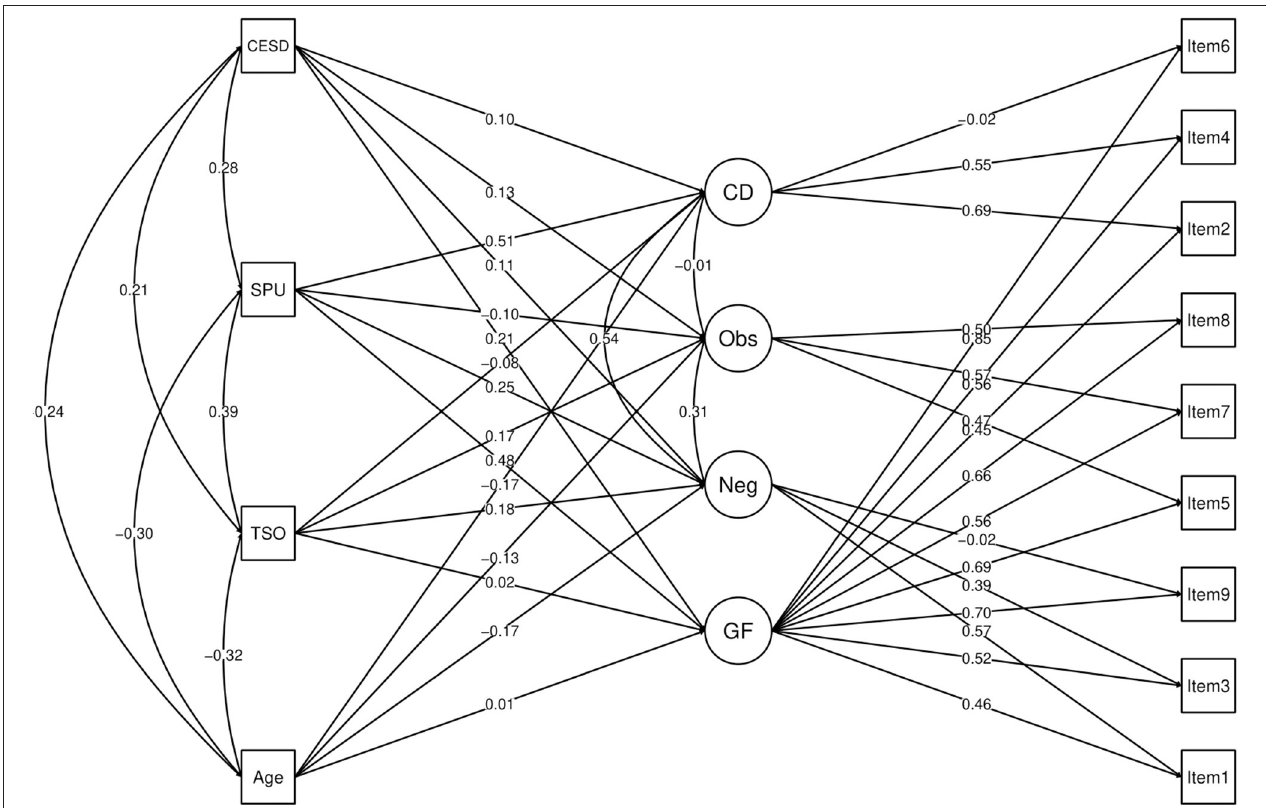
FIGURE 1 | Diagram of the MIMIC model of the PIUQ-SF-9 general factor and specific dimensions and the age of the respondents, time spent online, self-perception of problematic internet use, and depressive symptoms. MIMIC, Multiple Indicators Multiple Causes; CESD, Center for Epidemiologic Studies-Depression Scale; SPU, Self-perception of Problematic Use; TSO, Time Spent Online; CD, Control Disorder; Obs, Obsession; Neg, Neglect; GF, General Factor. A detailed measurement model assessment as Supplementary Material can be found on the following link: